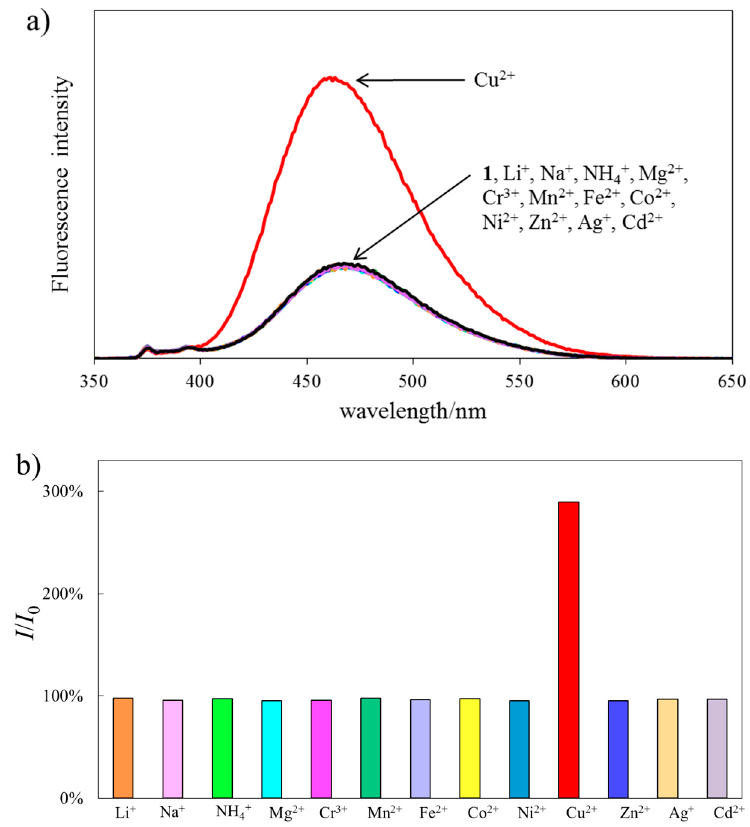
Figure 4. ( a ) Fluorescence spectra and ( b ) ratio of the fluorescence intensities monitored at 467 nm of bispyrenyl malonate 1 (10 µ M) in the presence of 1 equiv. of Li + , Na + , NH 4+ , Mg 2+ , Cr 3+ , Mn 2+ , Fe 2+ , Co 2+ , Ni 2+ , Cu 2+ , Zn 2+ , Ag + , and Cd 2+ in acetonitrile/chloroform (9:1, v / v ) (excitation wavelength: λ ex = 344 nm).